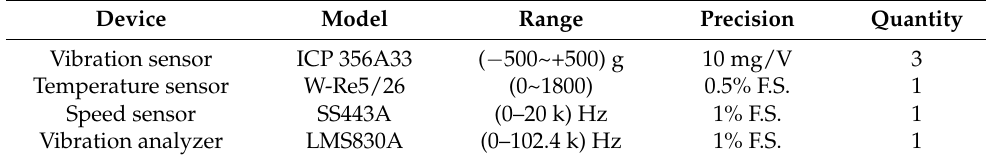
Figure 5. A photograph of the test rig. ( a ) The coaxial-rotor unit; ( b ) the gas generator; ( c ) the vibration sensor; and ( d ) the air–gas ratio controlling module. Table 1. The specification of the measurement